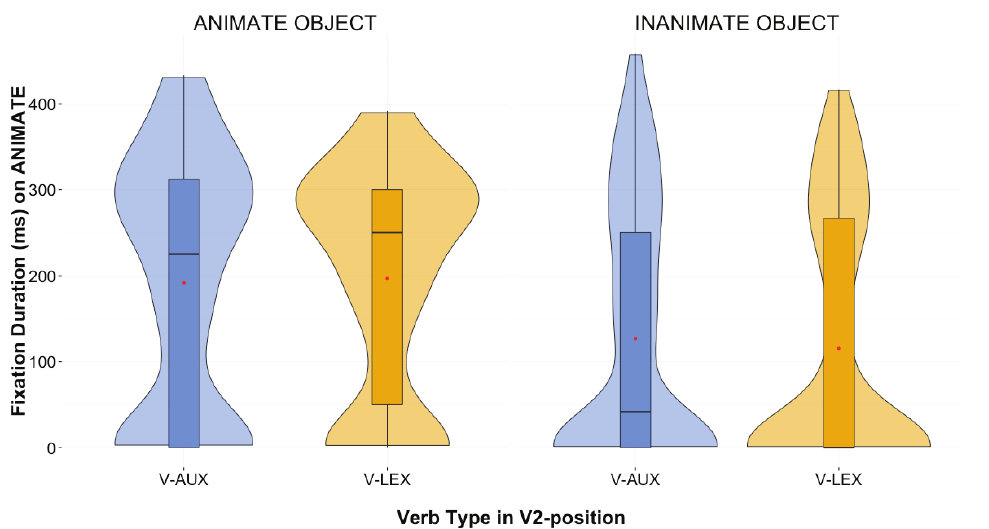
Figure 9: Violin/boxplot of fixation duration to the animate referent per condition in the late object integration window. The red dot encodes the mean, the black vertical line encodes the median, the top and bottom edges of the box encode the interquartile range and the transparent beans provide a density plot. Note that the statistical analysis was performed on the logit-transformed odds ratio of fixations to the animate referent over those to the inanimate